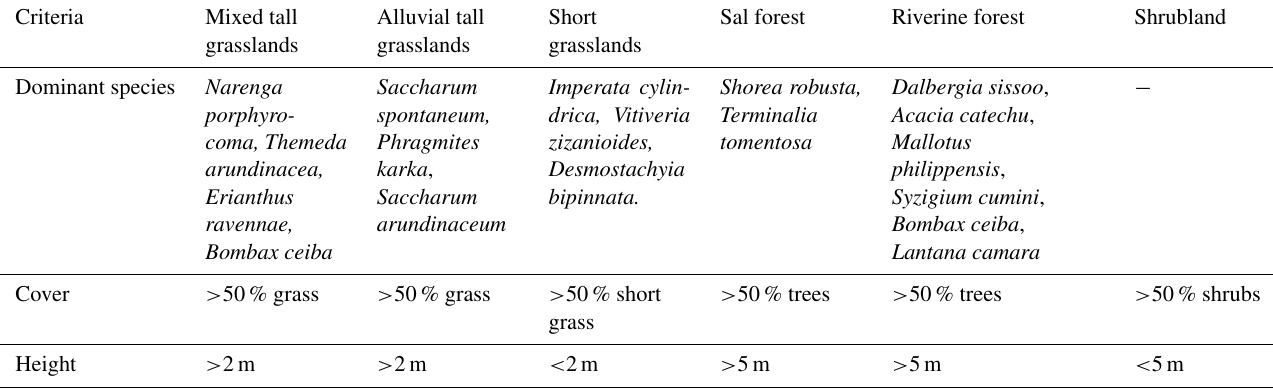
Table D1. Dominant species per vegetation type used for assigning classes. Cover and height are used for further discrimination of classes.